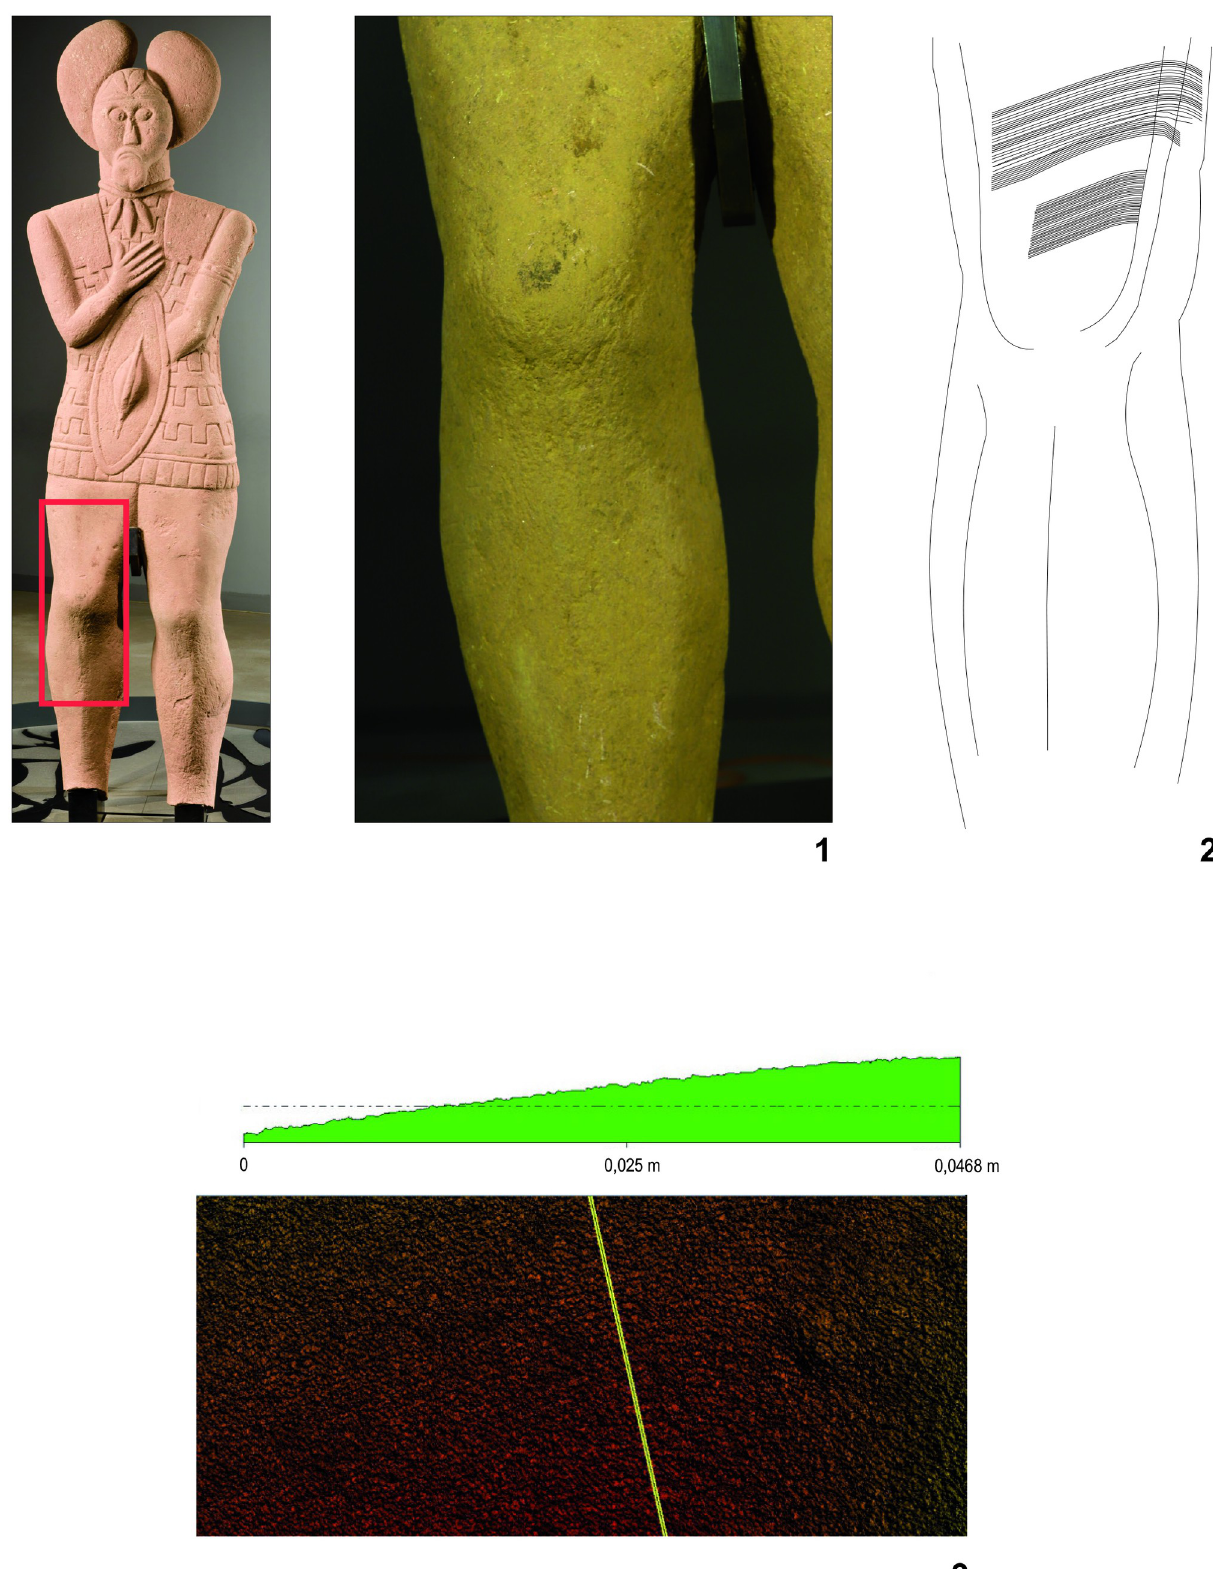
Fig 21. Statue 1 from Glauberg. 1 area of the thig with identified hair-thin parallel lines; 2 drawing of the documented situation; 3 the section of the area with the identified hair-thin parallel lines (author: M. Cihla and F. R. Va´clavı´k). https://doi.org/10.1371/journal.pone.0271353.g021 PLOS ONE | https://doi.org/10.1371/journal.pone.0271353 August 11,